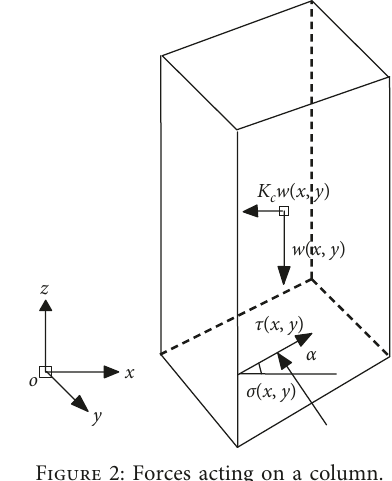
2: Forces acting on a column.